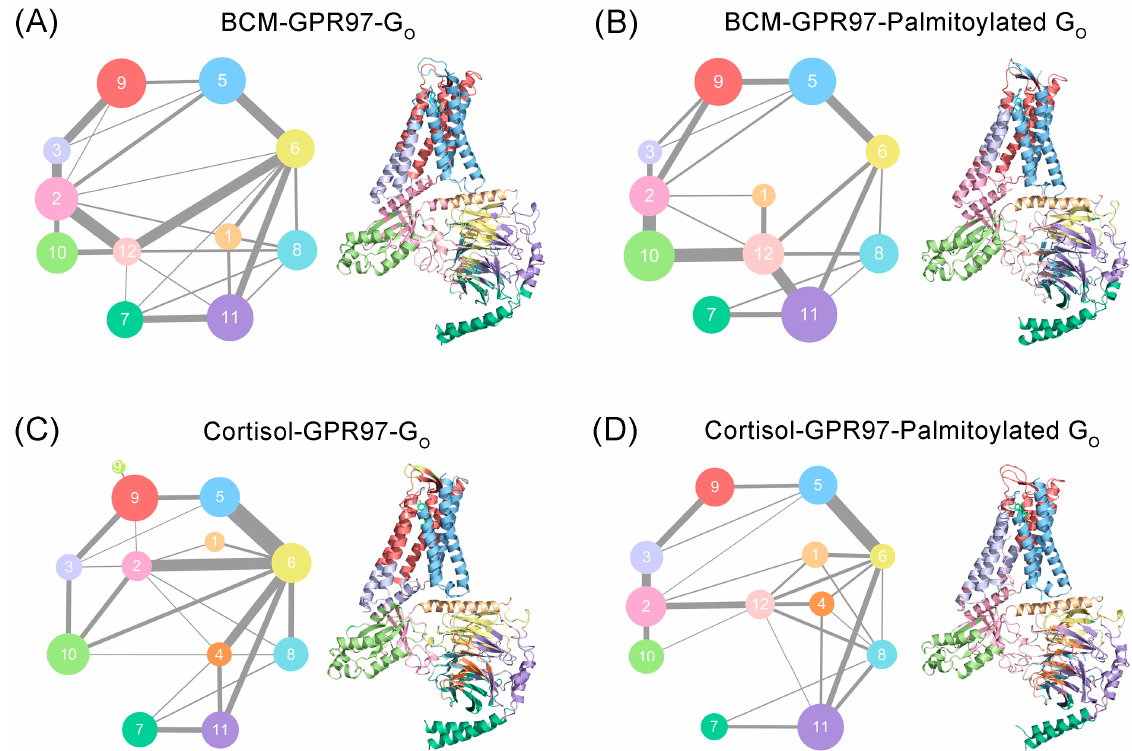
Figure 8. Colored community networks of BCM–GPR97–G o ( A ), BCM–GPR97–palmitoylated G o ( B ), cortisol–GPR97–G o ( C ), and cortisol–GPR97–palmitoylated G o ( D ). Each sphere represents an individual community with an area proportional to the number of residues it contains. The lines connecting different spheres visualize the intercommunity connections, while the thickness of the lines is proportional to the corresponding edge connectivity.